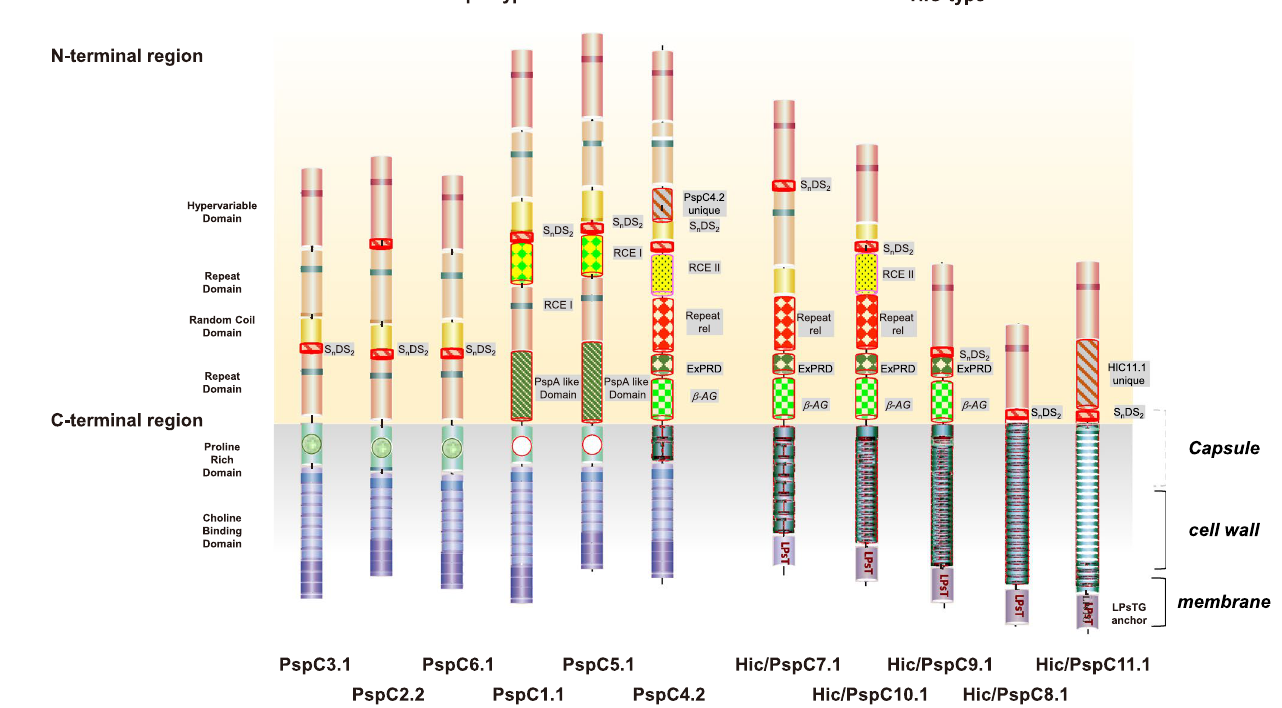
.Figure 4. Domain structure of the six PspC and five Hic variants. The domain architecture of PspC3.1 is shown on the left-hand side. The PspC and Hic variants differ in length and domain number. The proteins are arranged based on their overall homology. To reflect the different lengths of the regions proposed to be within cell wall and the external environment the proteins are centered along the axis which separates the N-terminal, α-helical region from the C-terminal region. The N-terminal and C-terminal regions are shown on yellow and grey backgrounds, respectively. Proteins are drawn to scale. The signal peptides and for the Hic-cluster the C-terminal region which is cleaved upon anchoring are not included. Domains previously identified within PspC3.1 are shown in solid colors. New domains are patterned, and their names are given alongside the domain on a grey background. The predicted binding sites for the human plasma protein Factor H within the Hypervariable Domain are shown by the purple bar and those of sIgA/pIgR within the Repeat Domains by green bars. The PspA like domain and the b-AG binding domains were identified by homology with the binding domains within S. pneumoniae protein PspA and the IBC protein from S. agalactiae